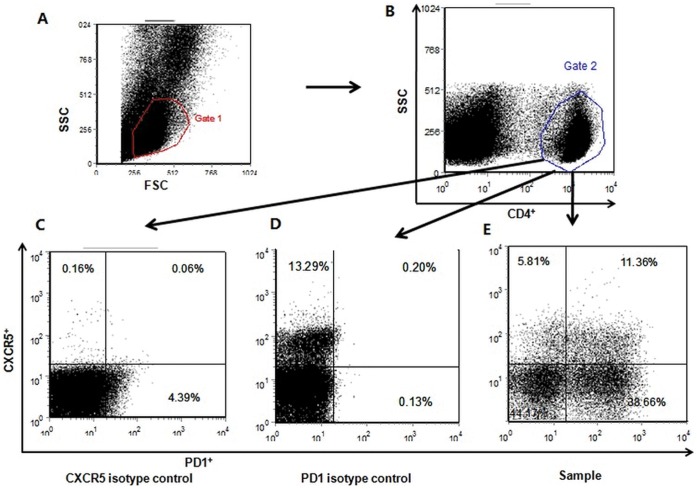
FACS analysis of Tfh cells.Three tubes from one sample, stained with 1) CD4, CXCR5 isotype control and PD1, 2) CD4, CXCR5 and PD1 isotype control, and 3) CD4, CXCR5 and PD1 separately, were analyzed at the same time. PBMCs are gated on the forward scatter of living cells and then centered on CD4+ T cells (A,B). After setting the threshold using isotype control staining for CXCR5 (C) and PD1 (D), the proportion of Tfh cells is analyzed as the percentage of CXCR5+ PD1+ cells within total CD4+ T cells (E).